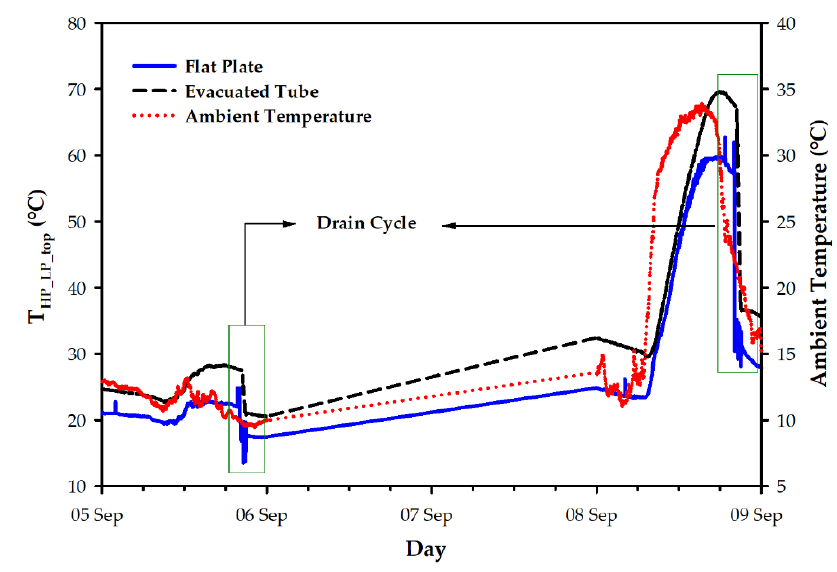
Figure 11. The response of the FP and ET to ambient temperature.